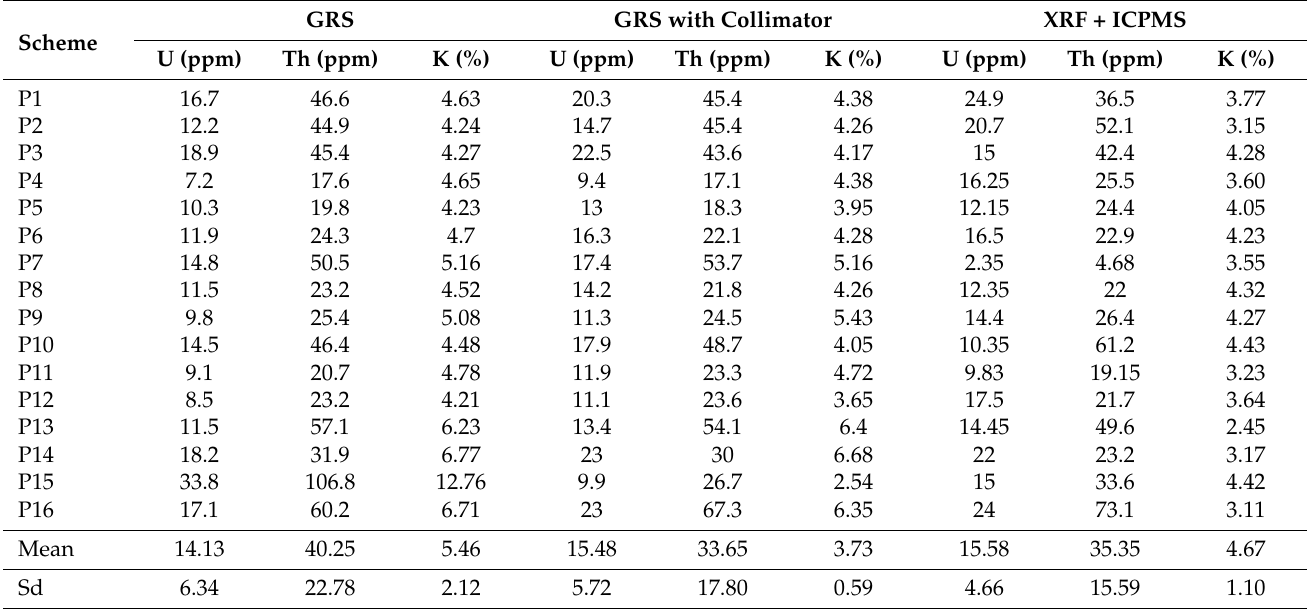
Table 3. Results of GRS measurements and geochemical